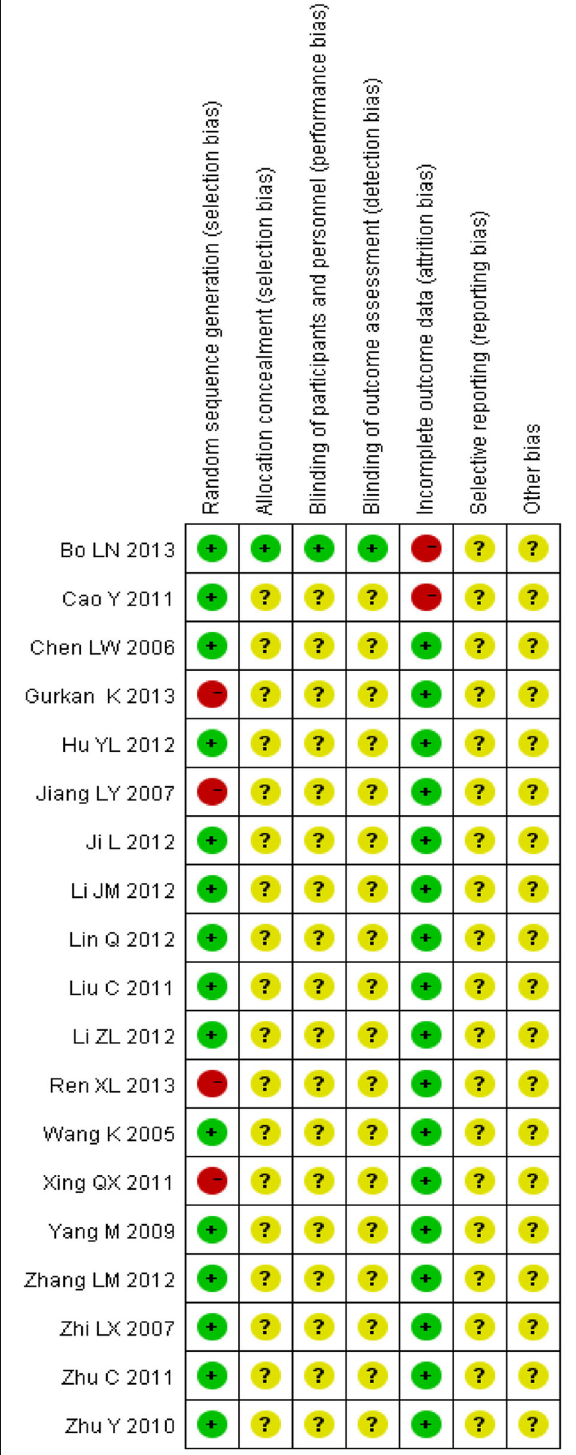
Fig. 8 Risk of bias summary: review authors ’ judgements about each risk of bias item for each included